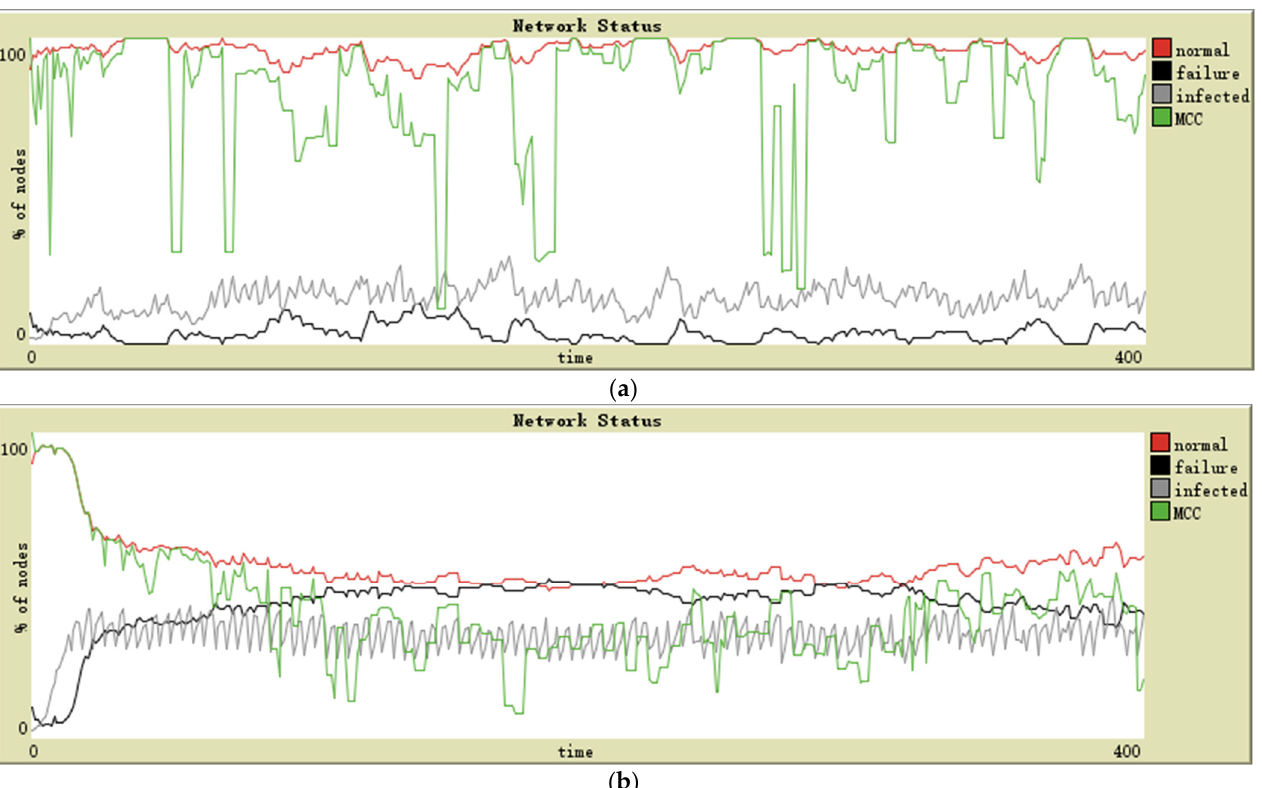
Figure 7. Simulation results of a ( a ) scale-free network, ( b ) small-world network.